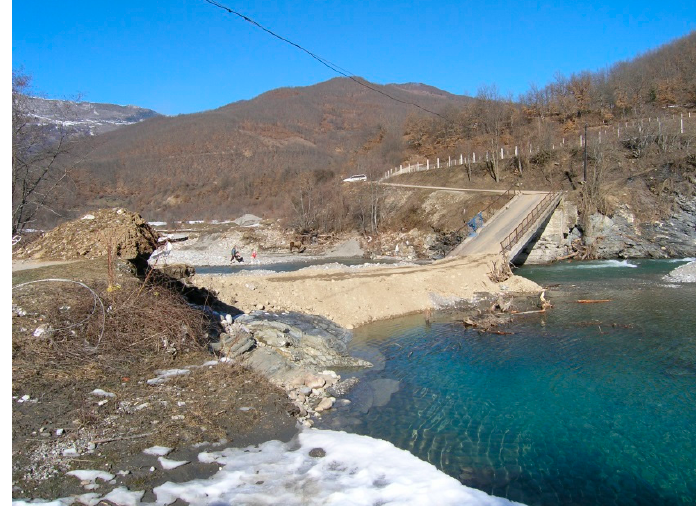
Figure 25. The Novsici bridge after the collapse.